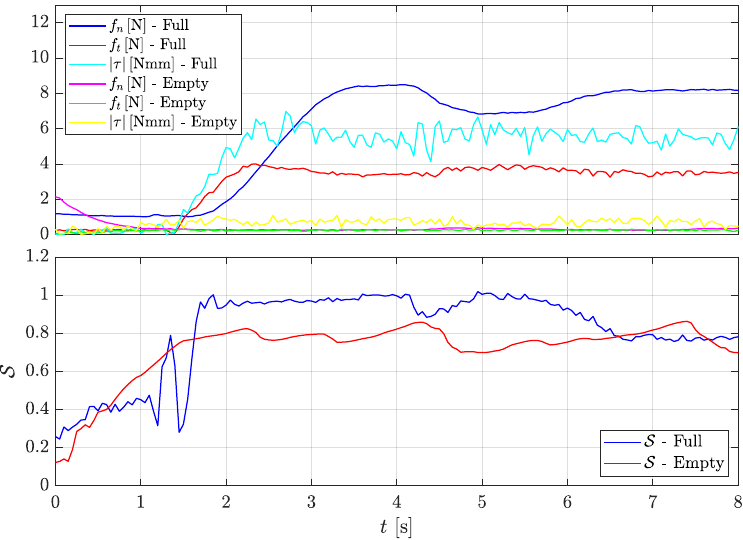
Figure 17. Fourth experiment: lifting the aluminum can. Top plot: grasp force, tangential force, and torsional moment for the full can (blue, red, and cyan respectively), grasp force, tangential force, and torsional moment for the empty can (magenta, green, and yellow respectively). Bottom plot: slippage indicator for the full and empty cans (blue and red,